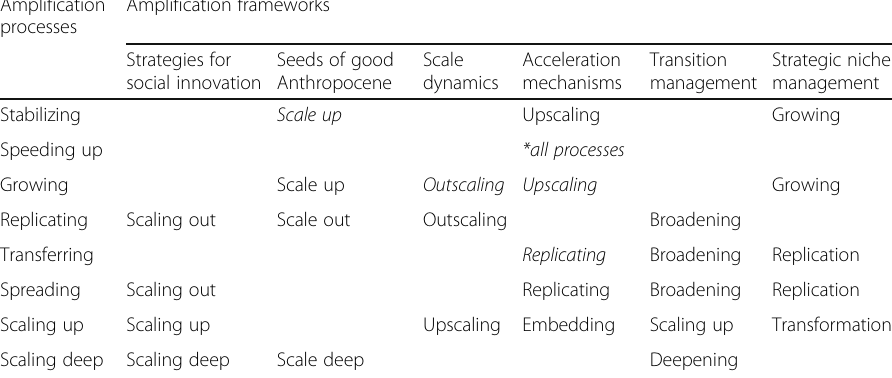
Table 3 Overview of how the amplification processes of different frameworks overlap and differ as well as how we grouped them under the amplification processes. We only analysed processes that focus on increasing impact and therefore excluded cross-cutting, partnering, instrumentalising, and accumulation in this analysis (Table 2; *Speeding up is based on the idea of acceleration mechanisms which processes can increase the pace of a transformation. Italics indicate not perfect matches. A more detailed overview of the integration of amplification processes is provided